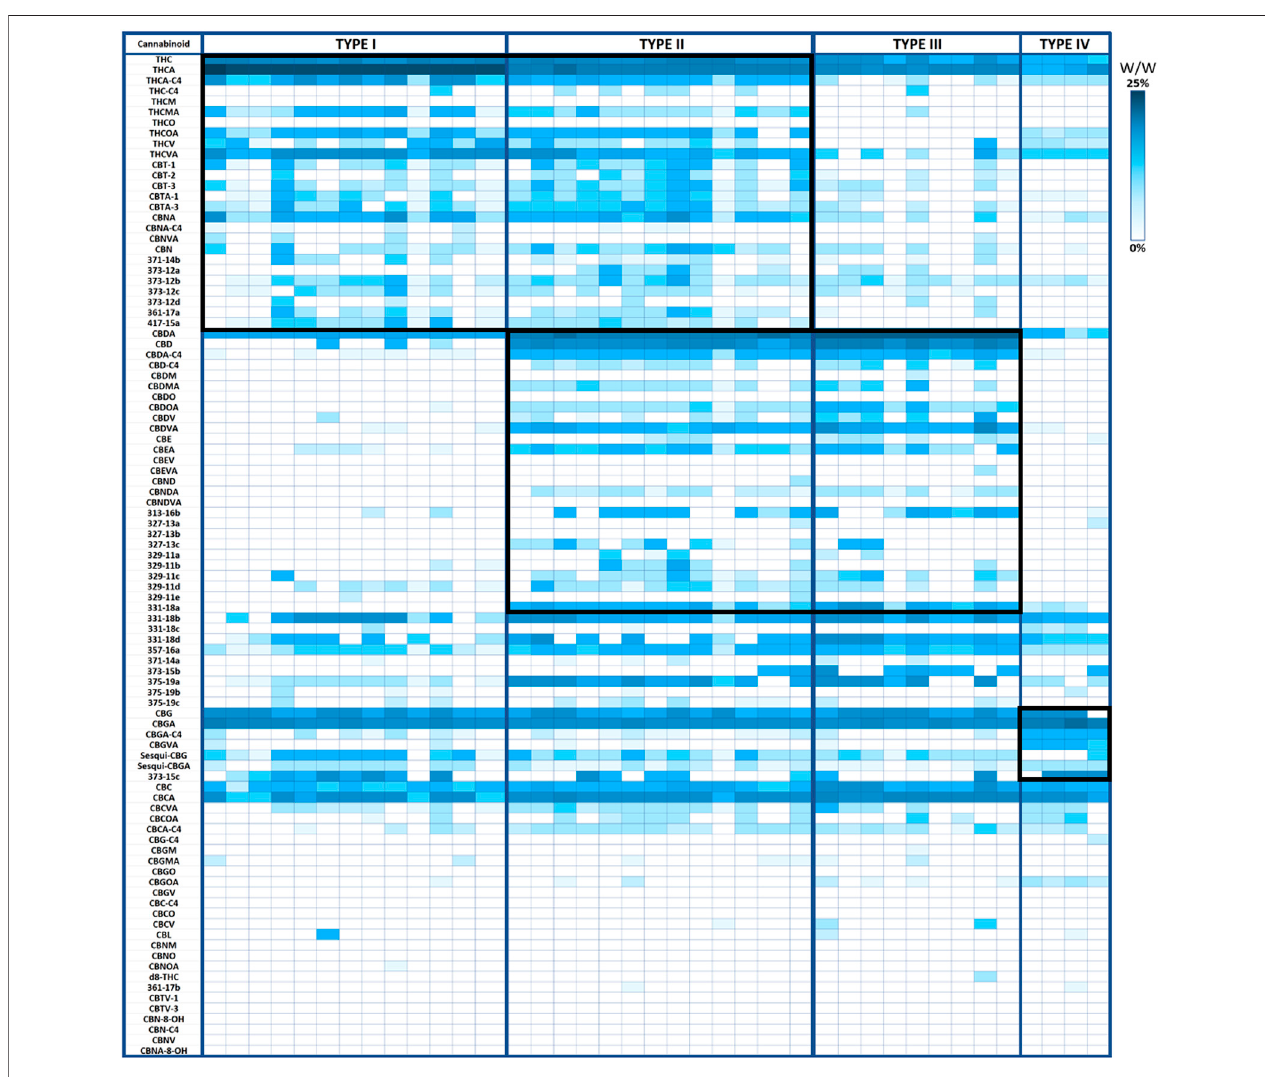
FIGURE2| Minor phytocannabinoidsareassociatedwithTypeI,TypeIIIandTypeIVchemovars. Heatmappresentingtheconcentration ofphytocannabinoids(% weight per weight) divided by chemovars. Type I chemovars de fi ned THCA > 20% ( n = 13), Type III chemovars de fi ned CBDA > 15% ( n = 9), Type II de fi ned THCA > 4% and CBDA > 10% ( n = 13), type IV de fi ned CBGA > 6% ( n = 4). Groups of unique phytocannabinoids are depicted by a surrounding black square.